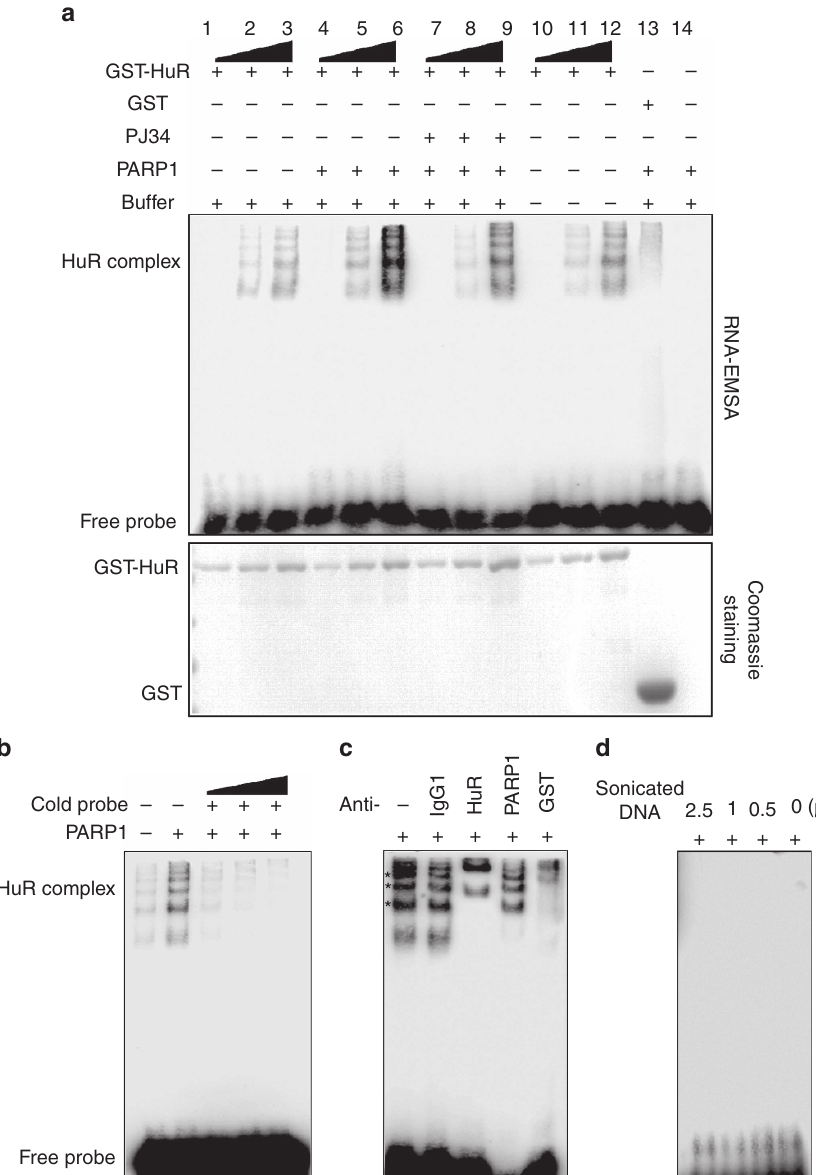
Figure 6 | PARP1 increases the binding of HuR with ARE-containing RNA. ( a ) Binding of the HuR with the ARE motif-containing RNA oligo is enhanced by PARylation. E. coli -expressing GST-HuR or GSTwas purified and eluted, and then subjected to PARylation, or not. Differently conditioned proteins were titrated (20-, 10- and 5-fold diluted, respectively) and then incubated with biotin-labelled tandem ARE repeat RNA oligos as indicated (upper panel). The gel retardation assay was performed to detect the binding of GST-HuR or GST to probes. The input amount of GST-HuR or GST within the binding system was visualized by Coomassie brilliant blue staining (lower panel). ( b ) Cold probe competition assay. GST-HuR was subjected to PARylation, or not, and then 10-fold diluted as indicated in lanes 2 and 5 in a. The diluted proteins were incubated with biotin-labelled probes in the presence or absence of 50-, 100- and 200-fold excessive non-labelled RNA. Gel retardation assays were performed. ( c ) Antibody supershift analysis. GST-HuR was subjected to PARylation and then 10-fold diluted as indicated in lane 5 in a. The diluted proteins were incubated with biotin-labelled probes in the presence of IgG1, or antibodies against HuR, PARP1 or GST, as indicated. Gel retardation assays were performed. ( d ) Sonicated DNA is not blocking the binding of PARP1 with the ARE motif-containing RNA oligo. Titrated sonicated DNA was utilized in PARP1 activation, and then ARE motif-containing RNA oligos were incubated with PARP1 in the binding buffer. Gel retardation assays were then